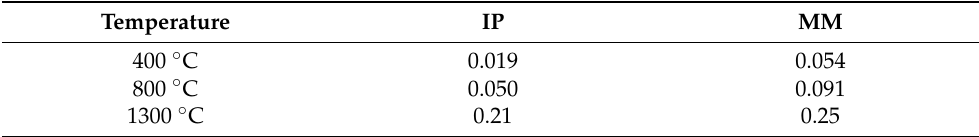
Table 2. Values of strain rate sensitivity (m) of IP and